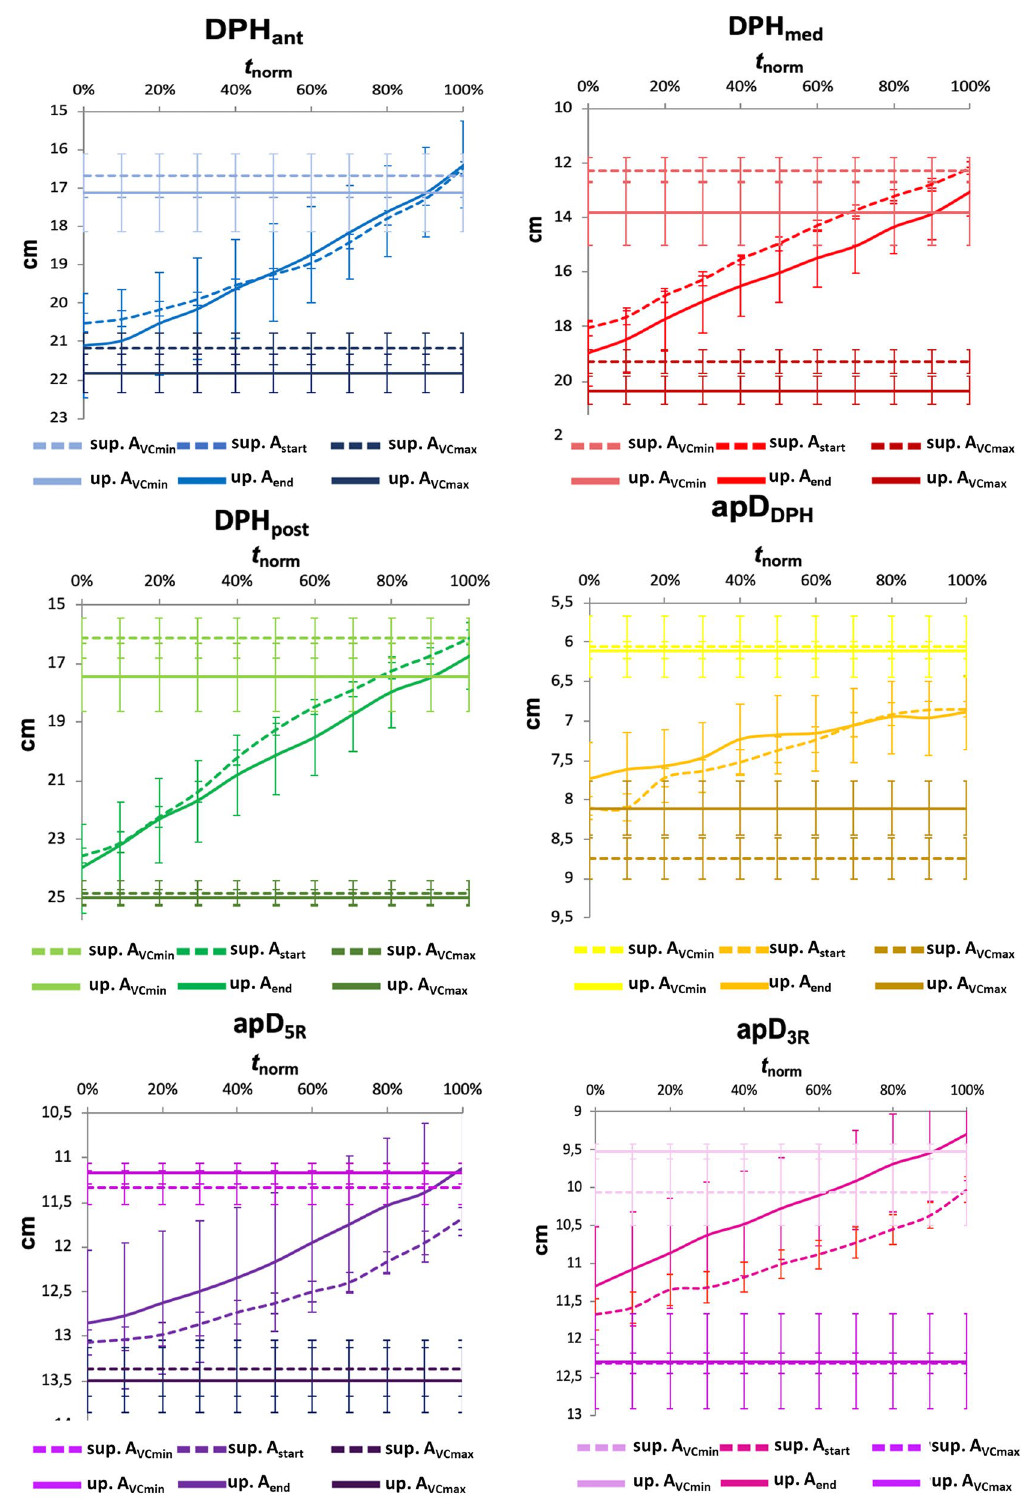
Figure 8. Cranial displacement of diaphragm motions during breathing and phonation; larger rip cage diameters during phonation in supine body position. Mean raw data for three subjects with standard error in cm is displayed on the y-axis, normalized time on the x-axis for each location. Dashed lines represent supine, solid lines upright data. Different shades of colour represent vital capacity inspiration/ expiration and sustained phonation. For better comparability, vital capacity maximum inspiration and expiration are included as horizontal